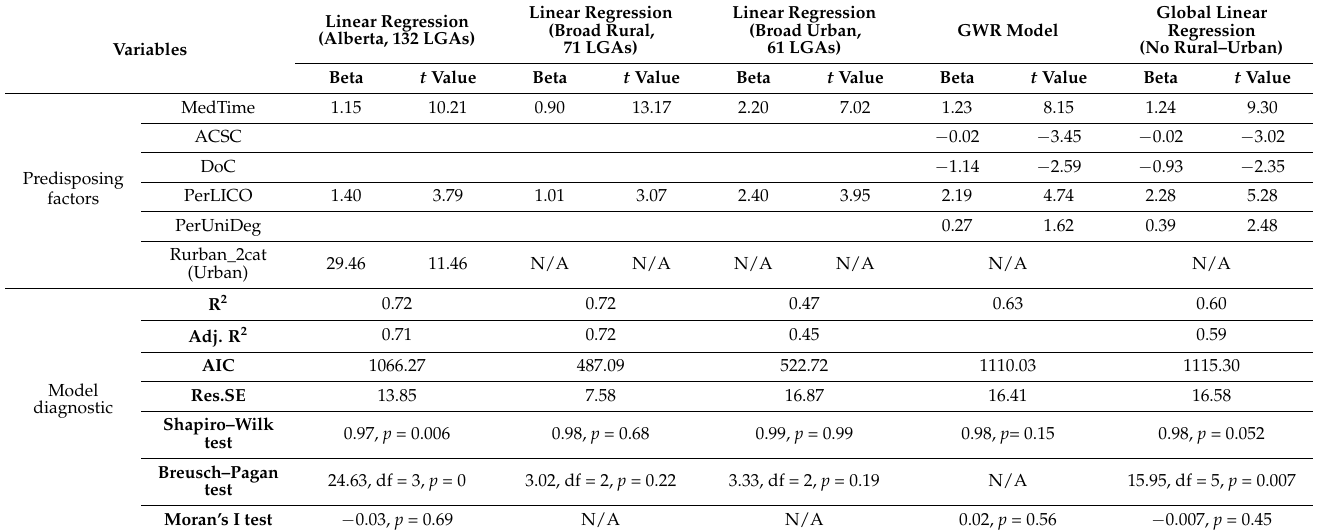
Table 3. Multivariate linear regression and GWR model of non-local PCP utilization at LGA level.